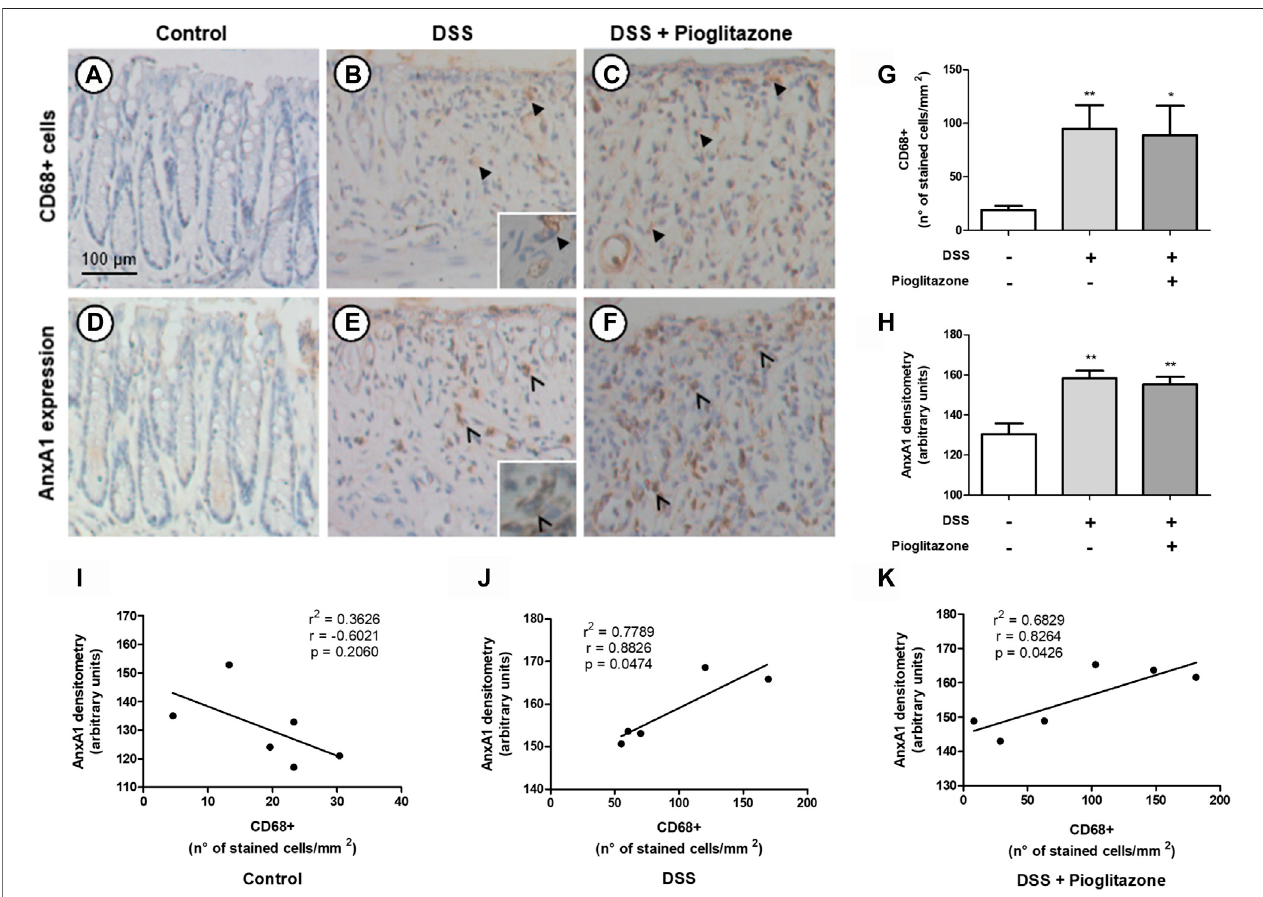
FIGURE 5 | Expression of AnxA1 and presence of CD68 + macrophages in tissue sections. Wild type and AnxA1 − / − mice were euthanized at the end of the experimental model; large intestines were harvested and colon paraf fi n-embedded sections were prepared. Number of CD68 + macrophages and staining intensity corresponding to AnxA1 were assessed via DAB-staining in serial sections (A – F) (thicker black arrows indicate CD68 + cells; thinner black arrows indicate staining corresponding to AnxA1 in macrophage-like cells), quanti fi ed (G,H) and correlated (I – K) . *, ** p < 0.05, 0.01 in comparison to the control group. Data were statisticallyanalyzedusingOne-WayANOVAfollowedbyTukey ’ spost-test( n (cid:2) 6).Resultsareexpressedasmean ± SE.Correspondingareasineachserialsectionwere analyzed using Pearson ’ s correlation